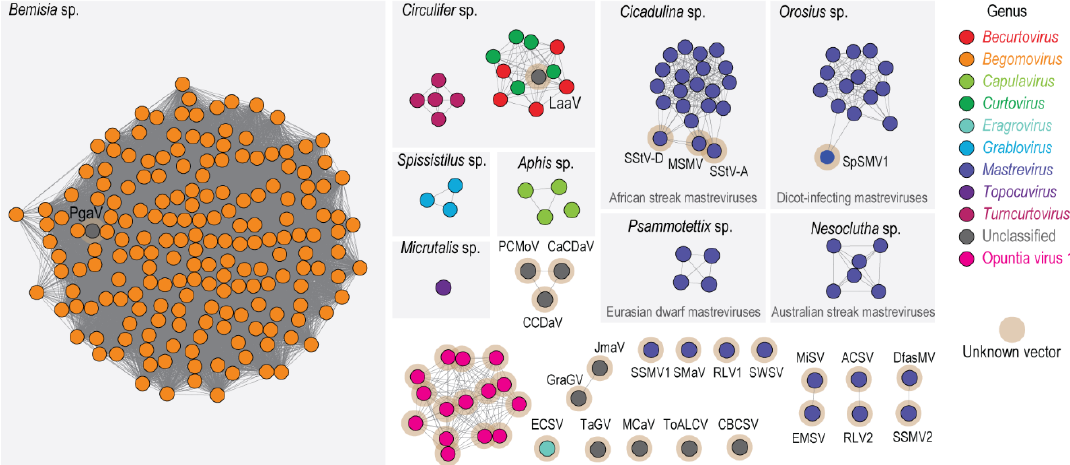
Figure 3. Sequence similarity network analysis of the CP amino acid sequences of representatives of the 15 genotypes from OpV1, together with those of the geminiviruses present in GenBank (dataset was created with an amino acid identity cut-off of 90%). The clusters are colored based on the genus or group. The genera that have known insect vectors are highlighted in a light grey box with the insect vector name displayed in the top. Clusters or singletons marked with a brown halo have no known insect vector associated with them. ACSV, Axonopus compressus streak virus; CaCDaV, Camellia chlorotic dwarf-associated virus; CCDaV, Camellia citrus chlorotic dwarf-associated virus; DfasMV, dragonfly-associated mastrevirus; CBCSV, common bean curly stunt virus; ECSV, Eragrostis curvula streak virus; EMSV, Eragrostis minor streak virus; GraGV, grapevine geminivirus; JmaV, Juncus maritimus-associated virus; LaaV, Limeum africanum-associated virus; MCaV, mulberry crinkle- associated virus; MiSV, Miscanthus streak virus; MSMV, maize streak Reunion virus; PCMoV, passion fruit chlorotic mottle virus; PgaV, Polygala garcinii-associated virus; RLV1, rice latent virus 1; RLV2, rice latent virus 2; SMaV, switchgrass mosaic-associated virus; SpSMV1, sweetpotato symptomless mastrevirus 1; SSMV1, Sporobolus striate mosaic virus 1; SSMV2, Sporobolus striate mosaic virus 2; SStV-A, sugarcane striate virus A; SStV-D, sugarcane striate virus D; SWSV, sugarcane white streak virus; TaGV, tomato-associated geminivirus; ToALCV, tomato apical leaf curl